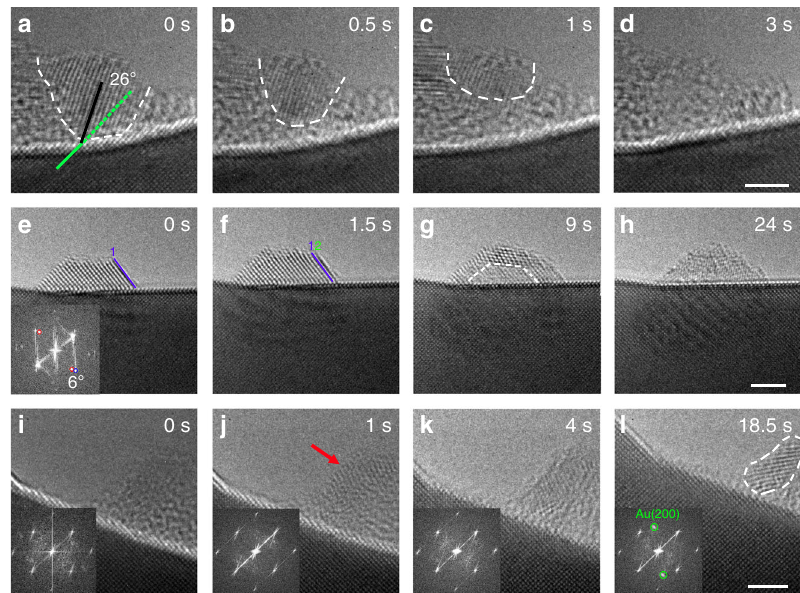
Fig. 4 Amorphization – crystallization oscillations of supported Au clusters. a – d In situ TEM image sequence showing the crystalline-to-amorphous transition for a signi fi cantly misaligned Au cluster. The black and green lines mark the misorientation angle between the Au cluster and the substrate. The white dashed lines outline the lower boundary of the crystalline Au cluster (Supplementary Movie 3). e – h In situ TEM image sequence showing the amorphization process in a slightly misaligned Au cluster (Supplementary Movie 4). Lines 1 and 2 mark the side surface of the Au cluster at 0 and 1.5 s, respectively. The white dashed lines outline the amorphized region of the Au cluster. Bottom-left inset in e : diffractogram showing the misalignment of the diffraction spots from the cluster (indicated by red and blue arrows). i – l In situ TEM images showing the recrystallization process in a large amorphous cluster (Supplementary Movie 5). The red arrow points to the surface area with partially ordered lattice fringes. The dashed white line circles out the crystallized area. Bottom-left insets are diffractograms, the diffraction spot pair marked by the green circles in ( l ) is associated with Au(200) lattice planes in the crystallized region of the cluster. All the in situ TEM images are captured in real time at 600 °C and 1 × 10 − 3 Torr of H 2 gas fl ow. Scale bar, 2 nm ( a – l